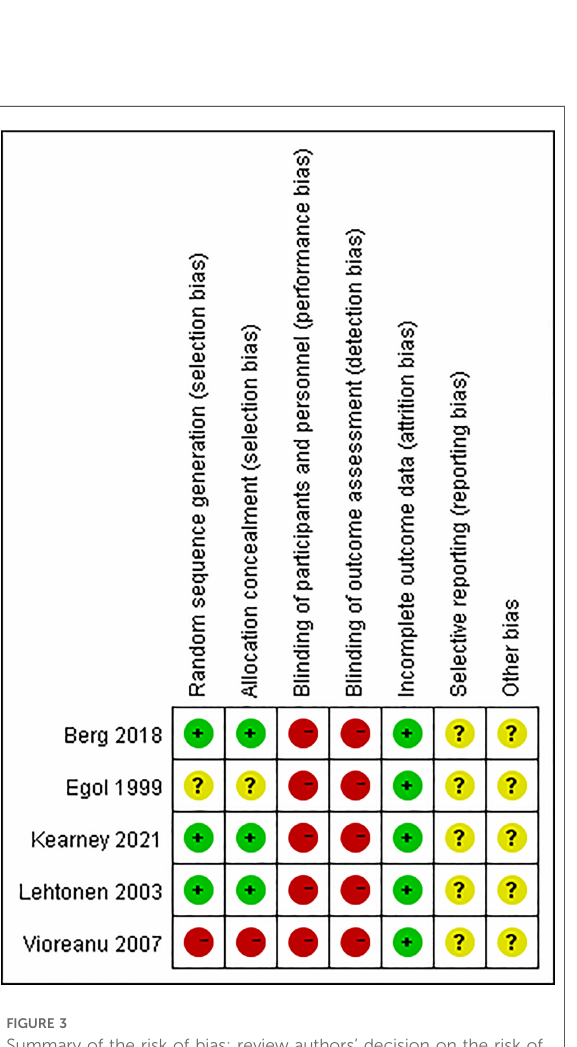
Figure S6 ), atrophy of the calf muscle (mean difference